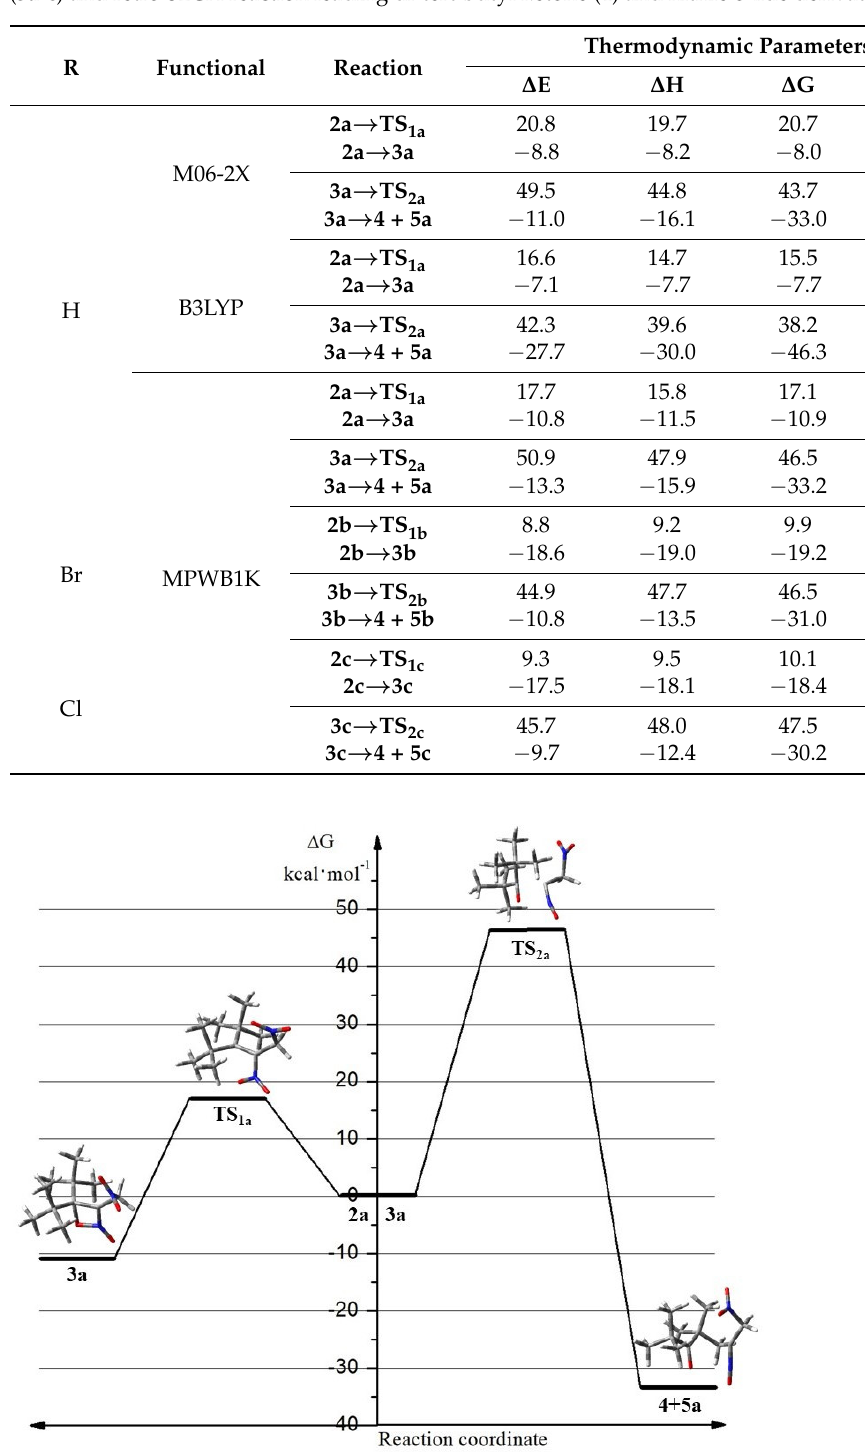
Table 1. The relative electronic energies, enthalpies, Gibbs free energy ( ∆ E, ∆ H, and ∆ G, in basic set, for the stationary points involved in the formation of 4H-[1,2]oxazete 2-oxide derivative ( 3a - c ) and retro-32CA reaction leading di-tert-butyl ketone ( 4 ) and nitrile oxide derivative ( 5a - c ). Thermodynamic Parameters R Functional Reaction